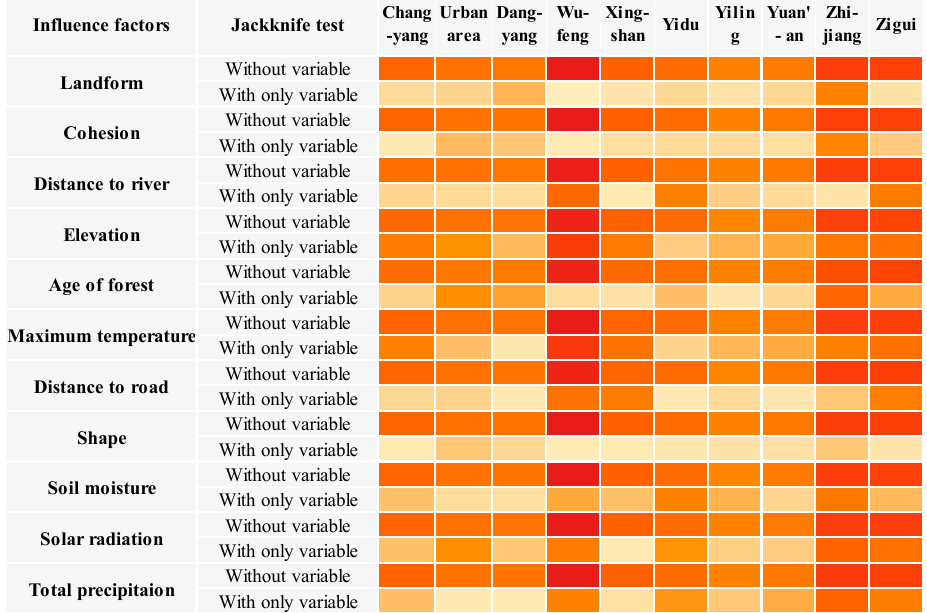
Figure 6. Jackknife result of different regions. The picture shows the results of the jackknife test of variable importance in ten regions of Yichang City. The graph is represented by a color scale, where the darker the color, the greater the gain.